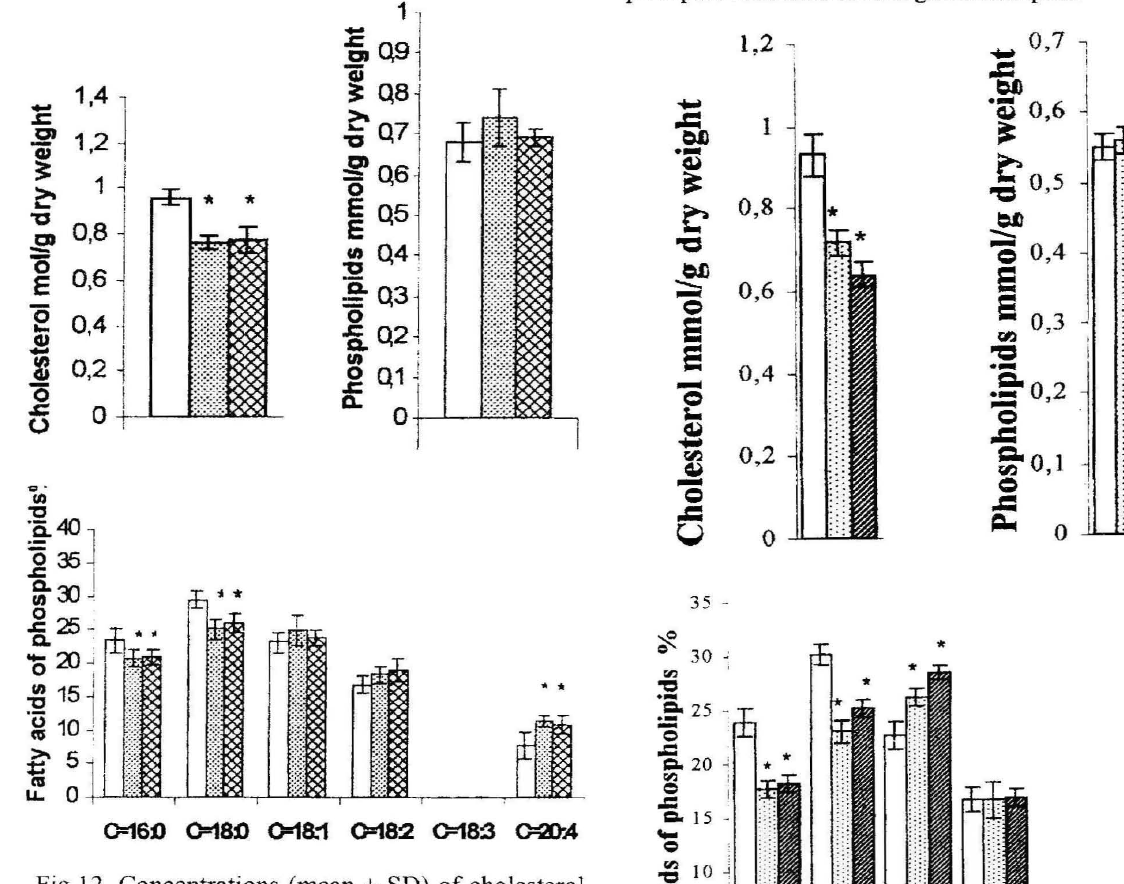
Fig.12. Concentrations (mean ± SD) of cholesterol and phospholipids, as well as fatty acid content in per cent (mean ± SD) of phospholipids in control samples (open bars) and in samples with 10 runol L-homocys tine/g wet weight (dotted bars), or with I ~mol L homocystine/g wet weight (hatched bars). Samples of rat liver tissue homogenate were used to test for phospholipid biosynthesis in vitro. Incubation medi um: Krebs-Ringer-phosphate buffer (pH=7.4) contain ing 0.3% albumin, fatty acid mixture and glycerol. Samples were incubated twice for 4 h at 37°C; the dif ference is statistically significant (P < 0.05).